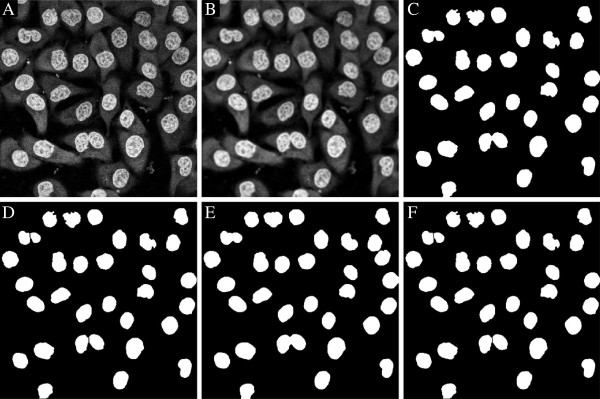
Segmentation of Hoechst stained Hela-Kyoto nuclei in 2D using segmct from Example 10. A) Input image showing stained nuclei, B) after edge enhancing diffusion, C) segmentation by adaptive thresholding (prm.method = ’adth’) without splitting of cells, and D) with splitting of cells. Note that the connected nuclei are now disconnected. E) Segmentation by iterative thresholding (prm.method = ’thrs’) without splitting, and F) after splitting. Both methods are successfull.